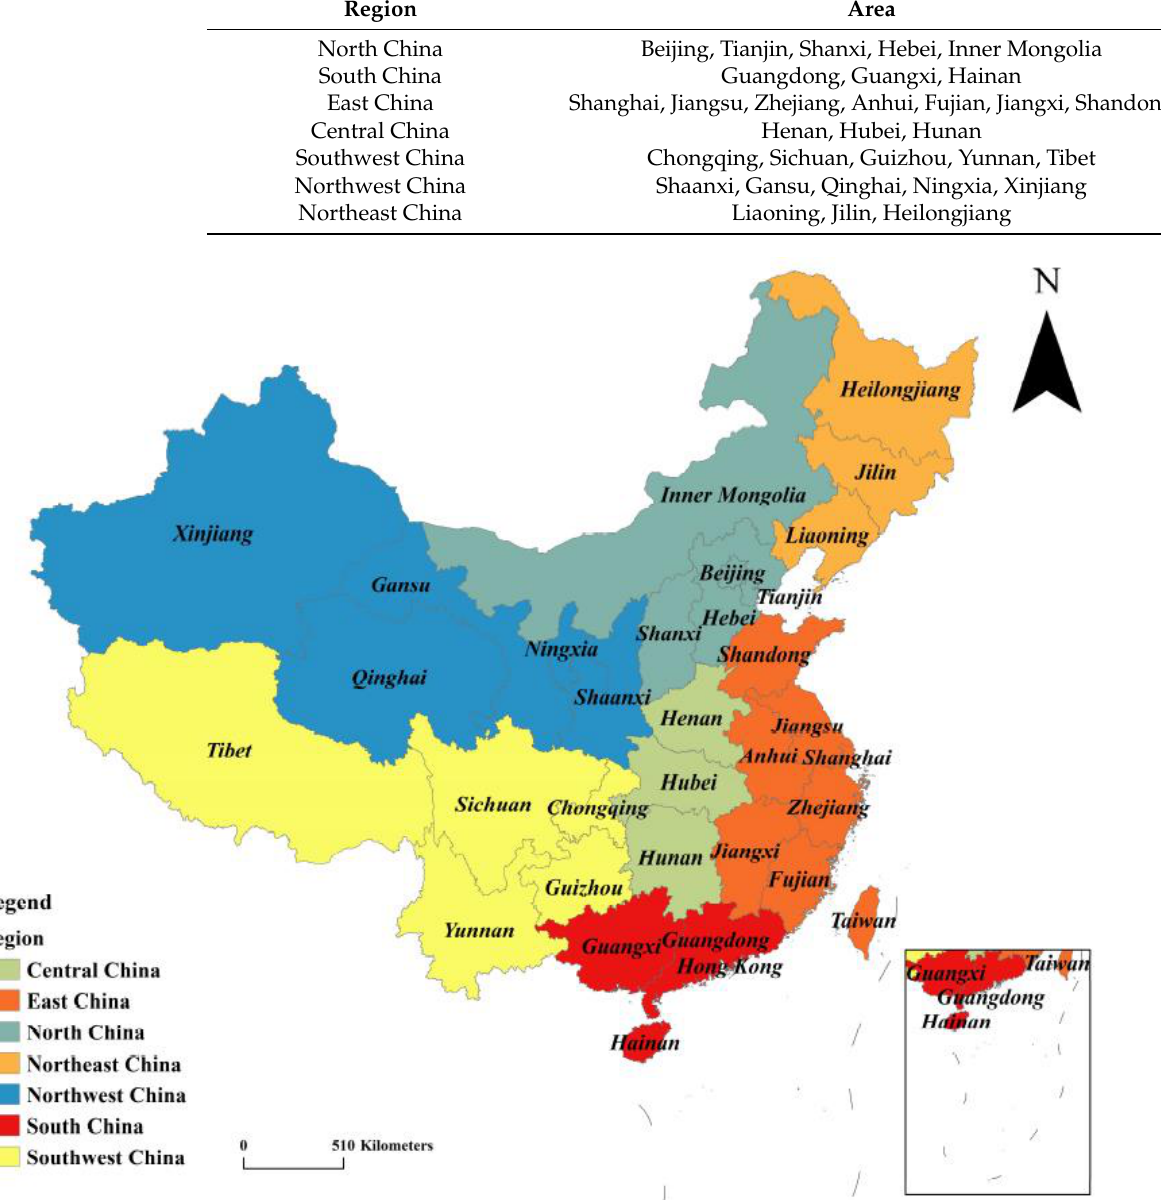
Figure 1. Administrative and geographical divisions of China.